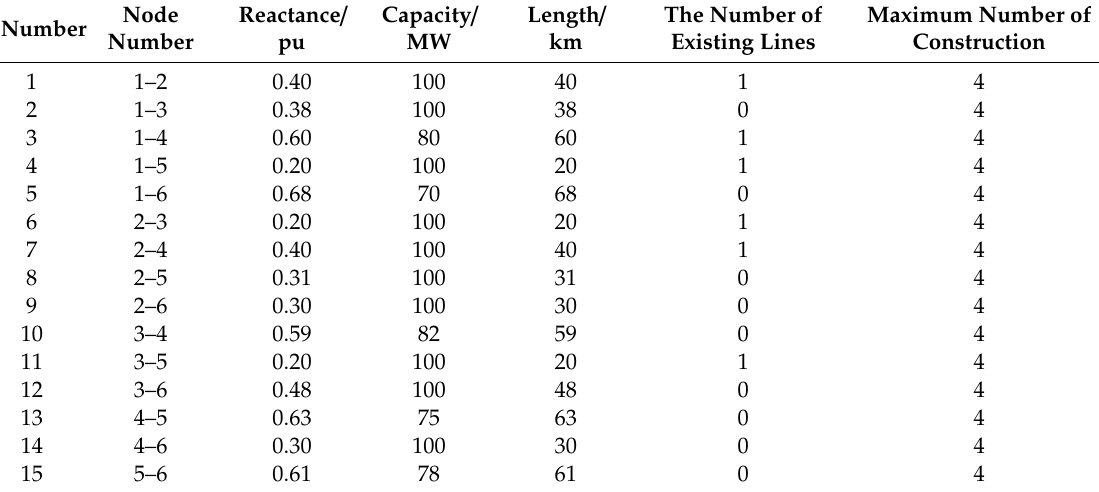
Table A1. Garver-6 system line data.